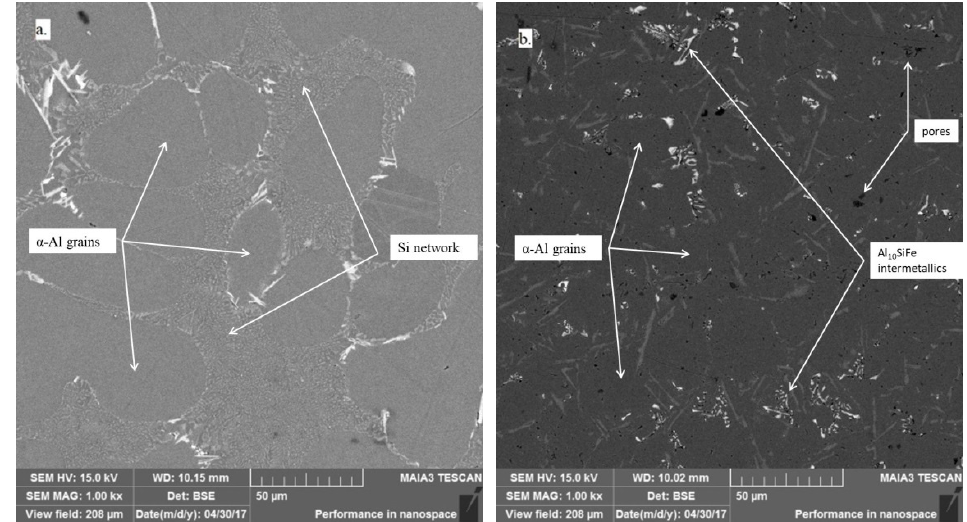
Figure 3. Scanning electron microscopy images of ( a ) the initial alloy and ( b ) the alloy treated by oxygen blowing.